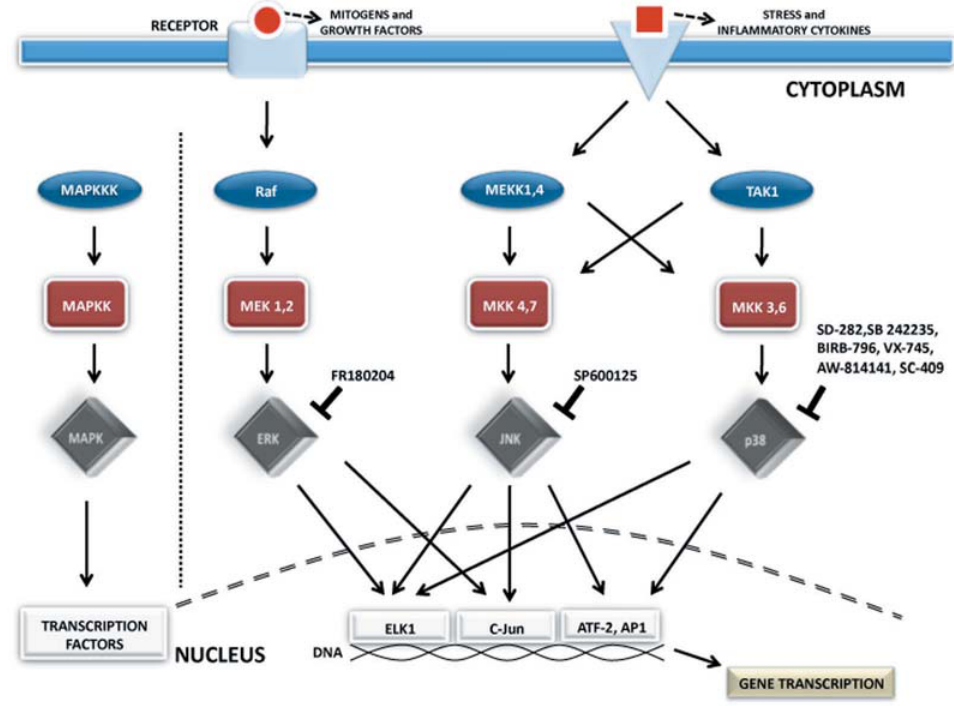
Figure 1- MAPK pathway: The three main sub-families of mitogen-activated protein kinases (MAPKs) are extracellular- regulated kinases (ERK), c-Jun N-terminal activated kinases (JNK) and p38 that mediate immune cell functional responses to different extracellular stimuli through multiple receptors. The MAPK cascade consists of a series of three-tired protein kinases, a MAPK and two upstream components, MAPK kinase (MAPKK) and MAPKK kinase (MAPKKK). Activation of the (cid:2)(cid:3)(cid:4)(cid:5)(cid:6)(cid:7)(cid:8)(cid:9)(cid:6)(cid:10)(cid:11)(cid:12)(cid:6)(cid:7)(cid:13)(cid:14)(cid:7)(cid:15)(cid:16)(cid:17)(cid:6)(cid:15)(cid:16)(cid:17)(cid:8)(cid:18)(cid:11)(cid:19)(cid:12)(cid:13)(cid:17)(cid:14)(cid:7)(cid:17)(cid:20)(cid:7)(cid:19)(cid:7)(cid:6)(cid:15)(cid:9)(cid:21)(cid:13)(cid:22)(cid:21)(cid:7)(cid:12)(cid:8)(cid:19)(cid:14)(cid:6)(cid:21)(cid:8)(cid:13)(cid:15)(cid:12)(cid:13)(cid:17)(cid:14)(cid:7)(cid:20)(cid:19)(cid:21)(cid:12)(cid:17)(cid:8)(cid:6)(cid:7)(cid:12)(cid:16)(cid:19)(cid:12)(cid:7)(cid:23)(cid:9)(cid:24)(cid:13)(cid:19)(cid:12)(cid:9)(cid:7)(cid:25)(cid:9)(cid:14)(cid:9)(cid:7)(cid:12)(cid:8)(cid:19)(cid:14)(cid:6)(cid:21)(cid:8)(cid:13)(cid:15)(cid:12)(cid:13)(cid:17)(cid:14)(cid:26)(cid:7)(cid:27)(cid:9)(cid:28)(cid:9)(cid:8)(cid:19)(cid:11)(cid:7)(cid:29)(cid:13)(cid:17)(cid:21)(cid:16)(cid:9)(cid:23)(cid:13)(cid:21)(cid:19)(cid:11)(cid:7) (cid:21)(cid:17)(cid:23)(cid:15)(cid:17)(cid:10)(cid:14)(cid:24)(cid:6)(cid:7) (cid:21)(cid:19)(cid:15)(cid:19)(cid:29)(cid:11)(cid:9)(cid:7) (cid:17)(cid:20)(cid:7) (cid:13)(cid:14)(cid:16)(cid:13)(cid:29)(cid:13)(cid:12)(cid:13)(cid:14)(cid:25)(cid:7) (cid:2)(cid:3)(cid:4)(cid:5)(cid:6)(cid:7) (cid:19)(cid:8)(cid:9)(cid:7) (cid:15)(cid:8)(cid:9)(cid:6)(cid:9)(cid:14)(cid:12)(cid:9)(cid:24)(cid:7) (cid:13)(cid:14)(cid:7) (cid:12)(cid:16)(cid:9)(cid:7) (cid:22)(cid:25)(cid:10)(cid:8)(cid:9)(cid:26)(cid:7) (cid:3)(cid:29)(cid:29)(cid:8)(cid:9)(cid:28)(cid:13)(cid:19)(cid:12)(cid:13)(cid:17)(cid:14)(cid:6)(cid:30)(cid:7) (cid:3)(cid:4)(cid:31)!(cid:7) (cid:19)(cid:21)(cid:12)(cid:13)(cid:28)(cid:19)(cid:12)(cid:13)(cid:14)(cid:25)(cid:7) (cid:15)(cid:8)(cid:17)(cid:12)(cid:9)(cid:13)(cid:14)"(cid:31)#(cid:7)